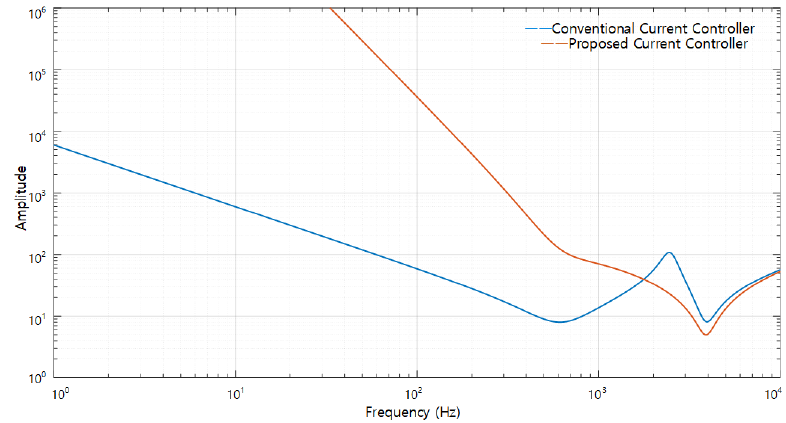
Figure 5. Dynamic stiffness of the conventional and proposed GCI current control system.